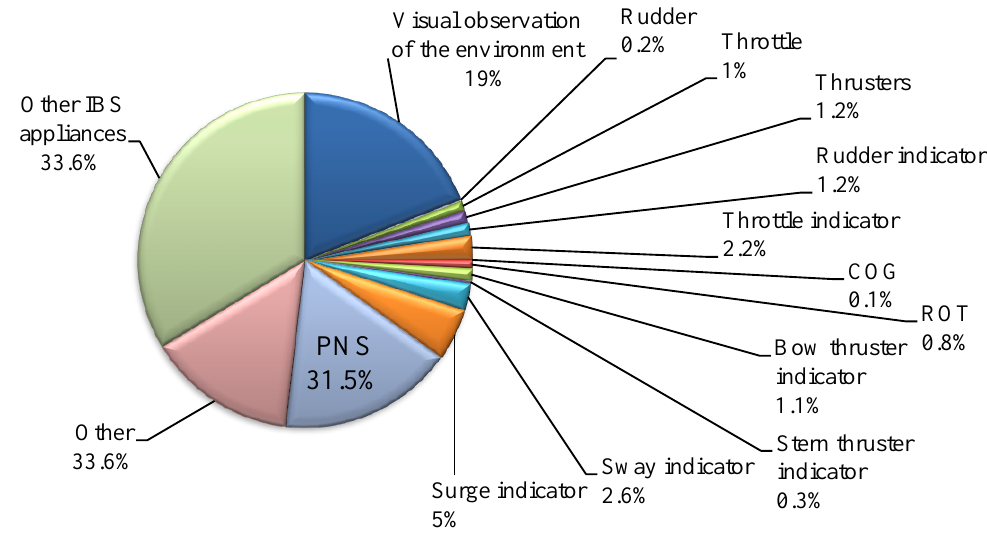
Figure 10. The percentage distribution of the navigator’s visual fixation on the most frequently used shipboard devices during maneuvers in a restricted area.